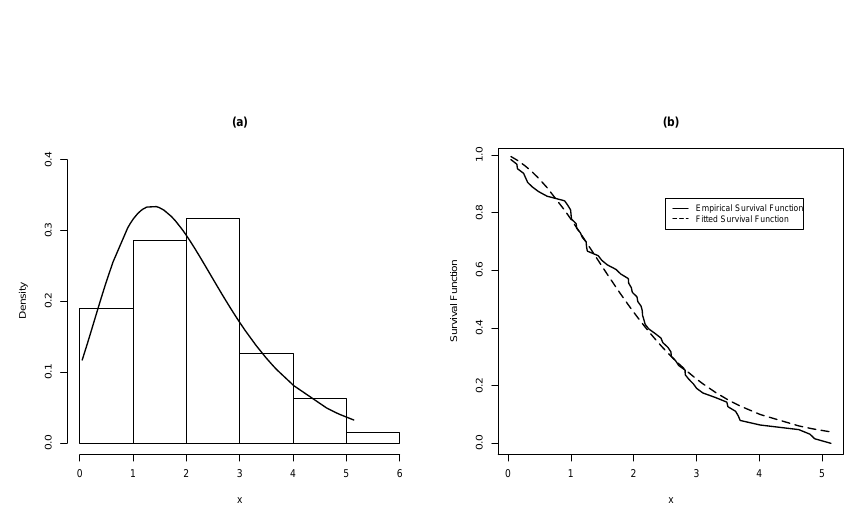
Figure 3 – Graphs of the fitted APTL density and survival functions for data set